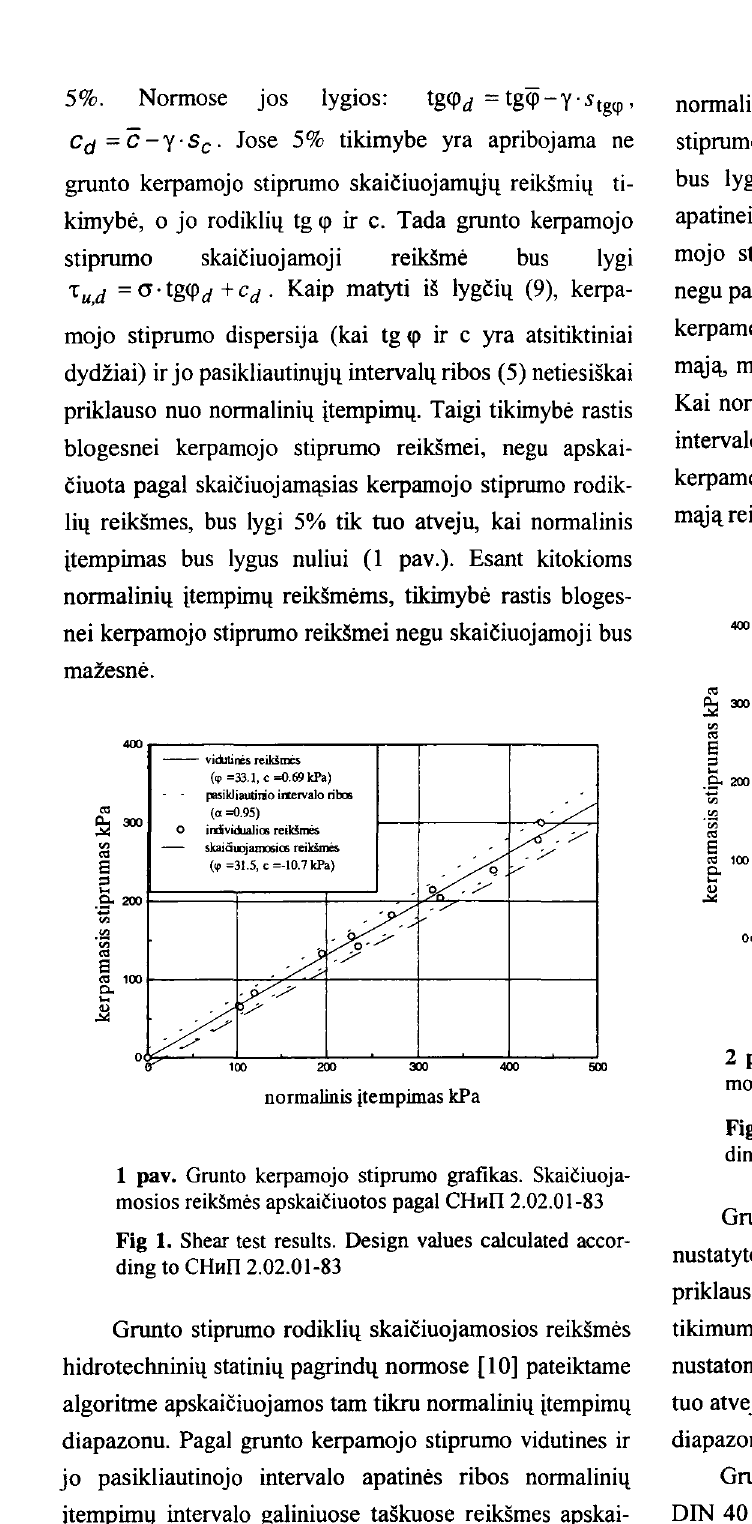
Fig 1. Shear test results. Design values calculated accor ding to CHHII 2.02.01-83